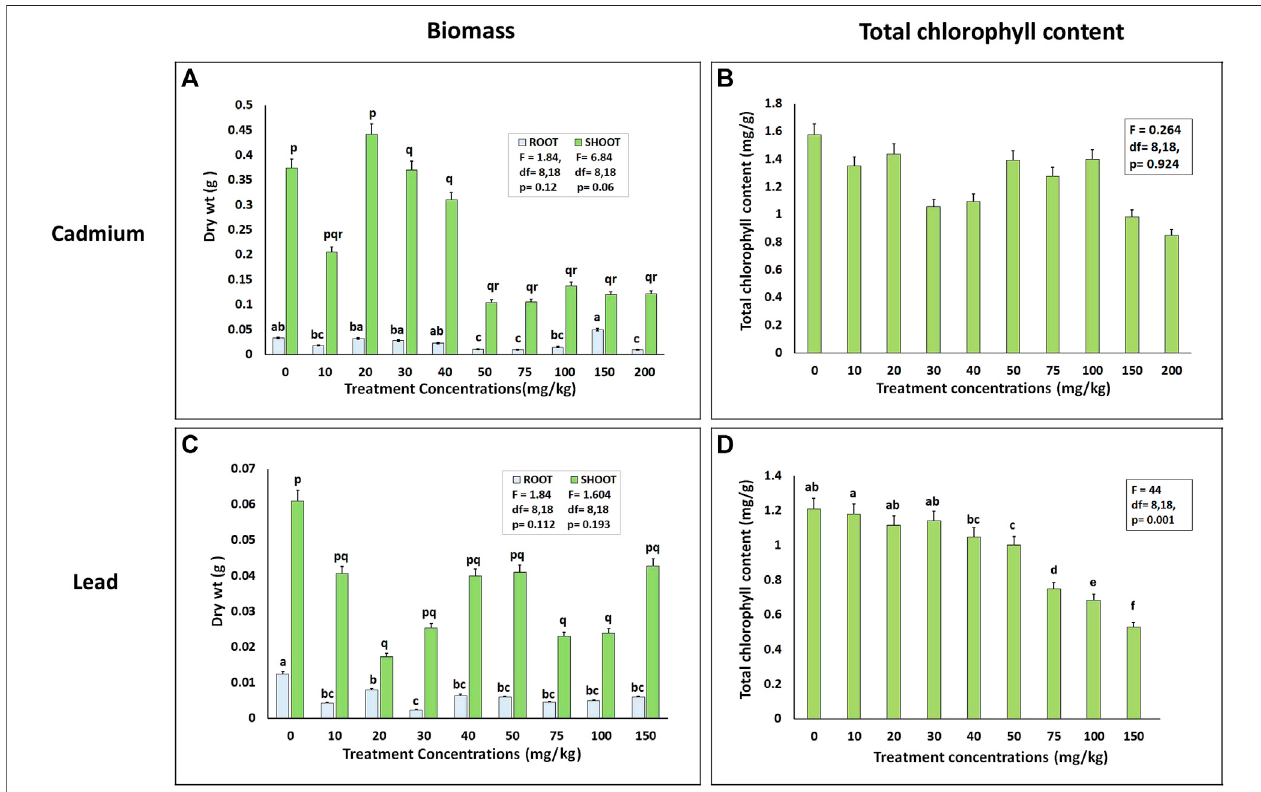
FIGURE5| Phytophysiologicaleffectsofheavymetalstresson Cleomerutidosperma atdifferenttestedconcentrationsof (A) and (B) cadmium, (C), and (D) leadin terms of biomass and total chlorophyll content, respectively. The bars marked with different alphabets (a,b,c,d and p,q,r,s) are signi fi cantly different from each other (F values and “ df ” are given in the respective graphs).